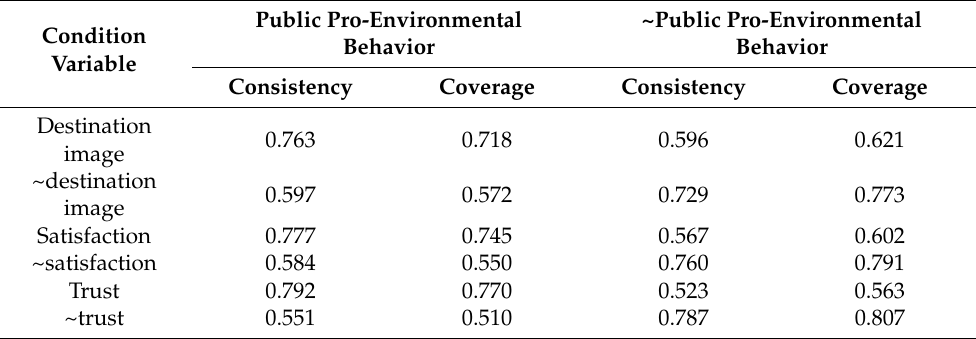
Table 16. Analysis of necessary conditions in pro-environmental behavior model.